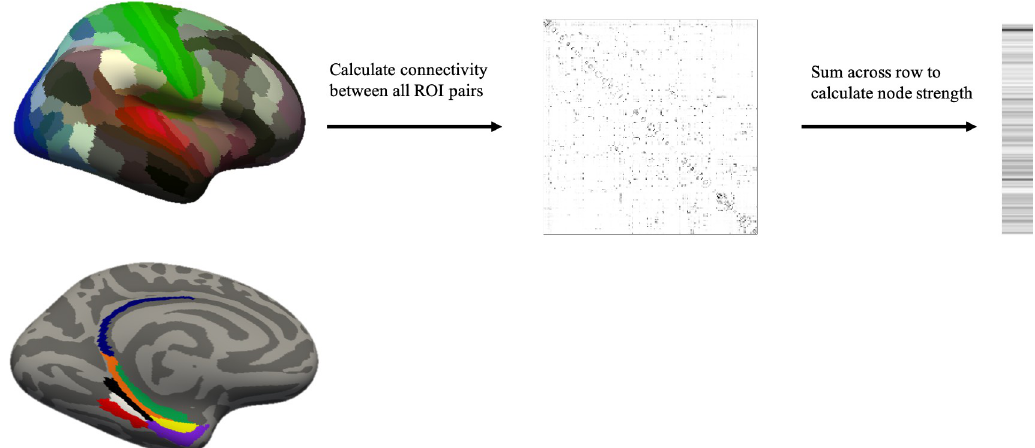
Fig 1. Overview of data processing. Top row: lateral view of the cortical HCP atlas (the subcortical ROIs are not visible in this view). Connectivity between all ROI pairs in the HCP-FreeSurfer atlas along with computed node strength are depicted. Bottom row: medial-inferior view of the 8 ROIs investigated shown. Retrosplenial cortex (blue), presubiculum (orange), parahippocampal area 1 (black), 2 (white) and 3 (red), perirhinal ectorhinal cortex (purple), entorhinal cortex (yellow), and hippocampus